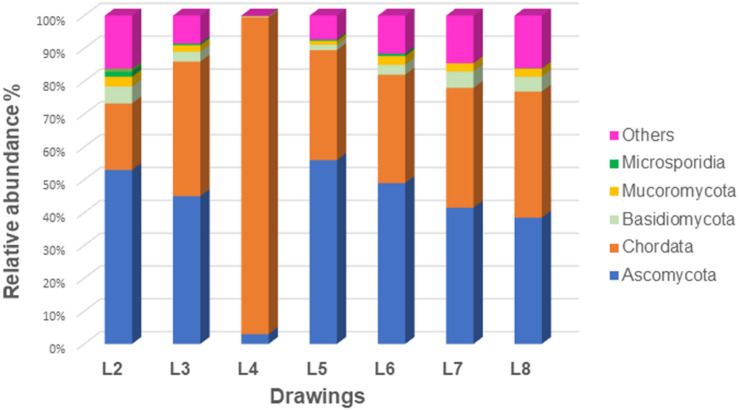
Relative abundance of the eukaryotic communities of all seven investigated drawings at the phylum level.